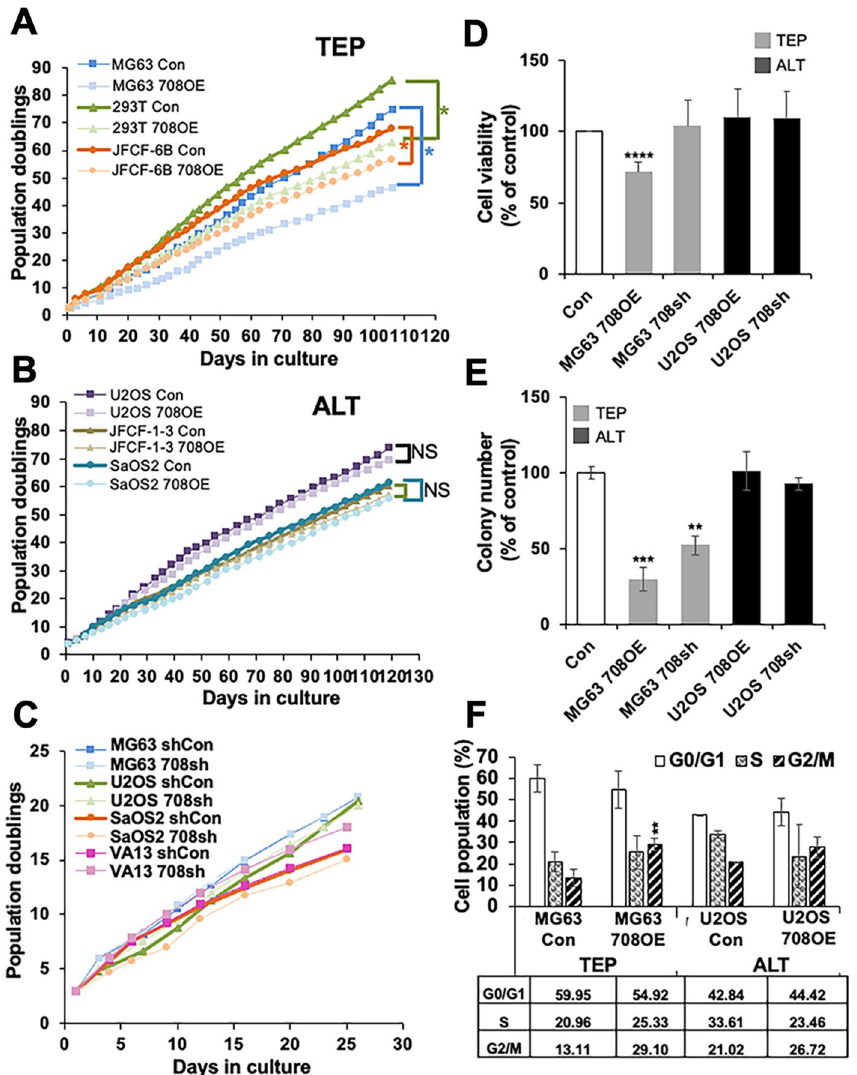
Figure 6. miR-708 regulates proliferation and colony formation only in TEP cells. ( A – C ) Growth curves of miR-708-overexpressing ( A , B ) and -deficient ( C ) TEP and ALT cell lines. ( A ) Overexpressing miR-708 decreased cell growth in TEP cells, ( B ) but not in ALT cells. ( C ) Depletion of miR-708 had no significant effect on growth rate of TEL (MG63) or ALT (U2OS, SaOS2, VA13) cells. ( D ) MTT assay in miR-708-overexpressing and -deficient TEP and ALT cell lines showing decrease in cell proliferation in miR-708-overexpressing TEP cells only ( E ) Colony forming assay showed that miR-708 overexpression decreased clonogenic capacity of TEP, but not ALT cells. ( F ) Cell cycle analysis of miR-overexpressing TEP and ALT cells showing strong G2/M arrest in TEP cells. Each data set represents the mean ± SD for at least 3 independent experiments. Con: control; 708OE: miR-708 expression; 708sh: miR-708 knock-down using short-hairpin interfering RNA. ** p < 0.01; *** p < 0.001; **** p <